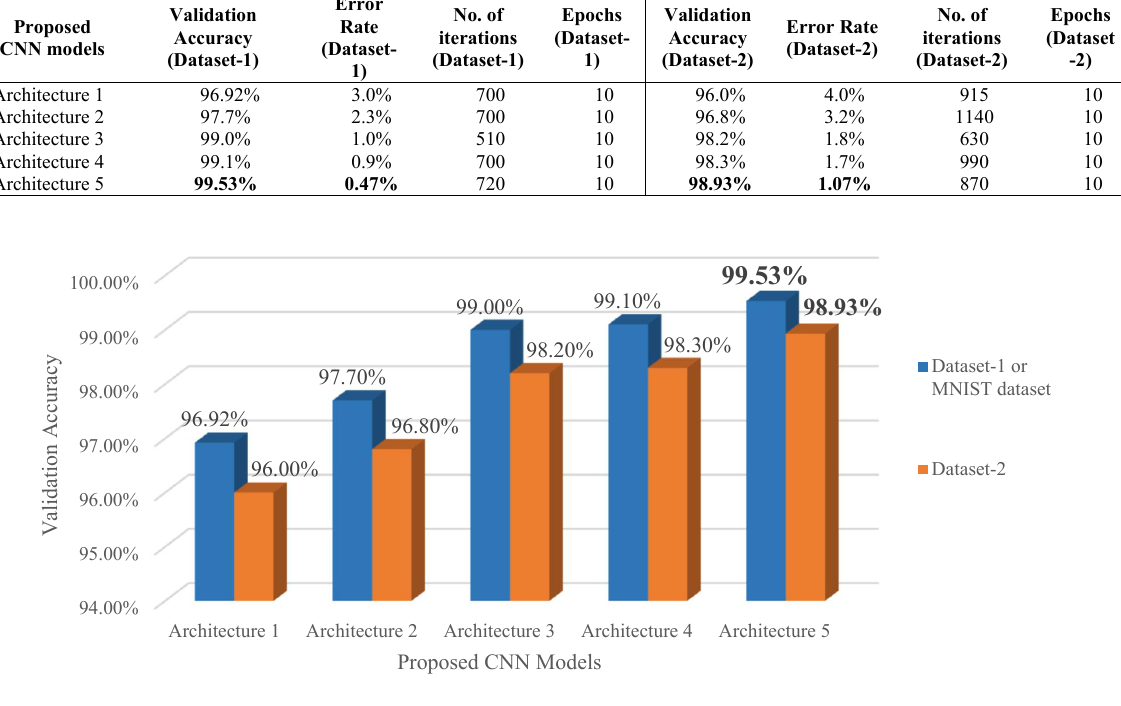
Fig. 7 Graphical representation of the validation accuracy of the proposed CNN